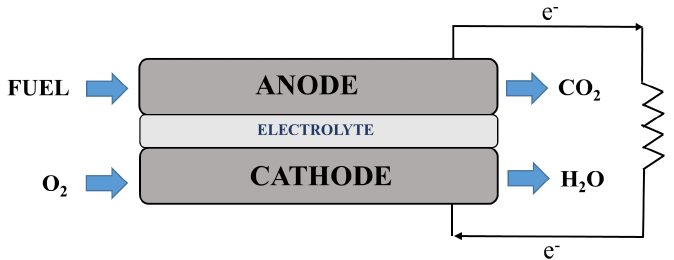
Figure 1. Representative scheme of a biofuel cell operation: the fuel is oxidized at the anode, and oxygen is reduced at the cathode so that chemical energy is converted to electrical energy. 2. Enzymatic Cascades In recent years, research into EBFCs has focused on understanding how enzymes function on electrode surfaces and on developing methods for the application of enzymes on these surfaces. To enhance the power density of EBFCs, the degree of fuel oxidation must be increased so that all electrons can be harvested from complex fuels [15]. EBFCs generally employ enzymes to collect energy from biofuels [3,11,16]. These enzymes cata- lyze the oxidation of various fuels at room temperature and in mild aqueous environ- ments, offering high theoretical efficiency while producing nontoxic reaction residues [12,15,17,18]. To increase the degree of fuel oxidation, multiple enzymes have been immobilized on electrode surfaces [19]. These systems can oxidize more complex fuels, thereby enhanc- poorly stable bioelectrodes [12]. Different specific operating conditions (pH, temperature, substrate specificity, and electrolytes) of the enzymes in the enzymatic cascade limit film